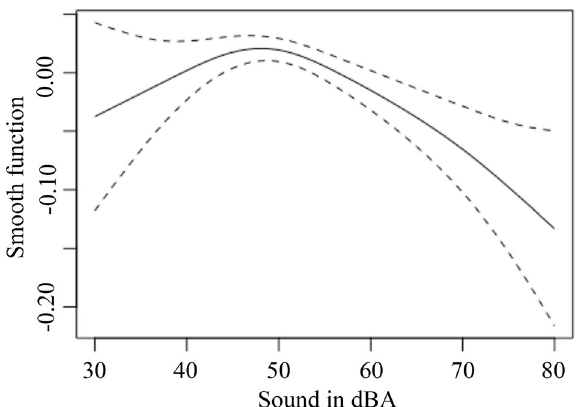
Fig. 1 Component smooth function of sound level in GAMM for physiological wellbeing as a bivariate function of SDNN and normalized-HF. The solid line indicates how physiological wellbeing varies as a function of sound level, while the dashed lines are con fi dence